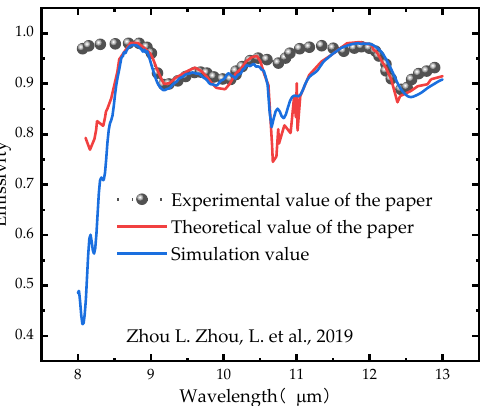
Figure 4. The experimental value and theoretical value in Zhou’s paper [29] compared with the simulated emissivity value of the FDTD method.